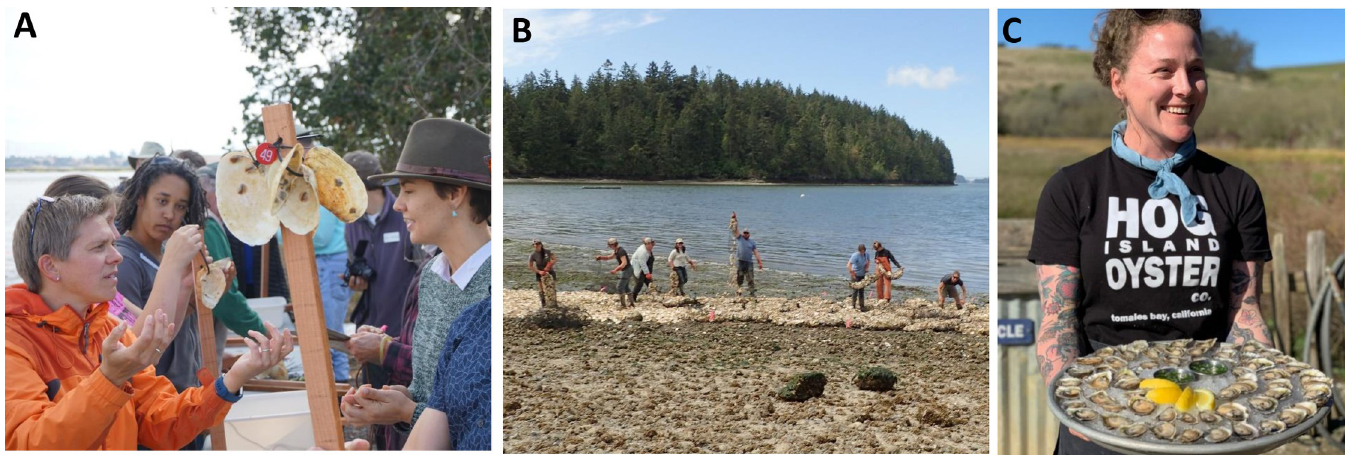
Fig 4. Examples of different approaches to implementing conservation aquaculture with Olympia oysters. A) Restoration with hatchery-raised juveniles led by a coastal management organization. Staff of the Elkhorn Slough National Estuarine Research Reserve, with community volunteers and partners, assemble stakes with clam shells bearing hatchery-raised juveniles. (Photo: B. Tougher). B) Community restoration. Staff members from the Swinomish Indian Tribal Community work with AmeriCorps volunteers from the Nooksack Salmon Enhancement Association to enhance habitat for Olympia oysters on Swinomish tidelands. (Photo: J. Barber); C) Commercial production and sale of Olympia oysters (Photo: M. Wilkinson, Hog Island Oyster Company). All individuals shown in images provided prior